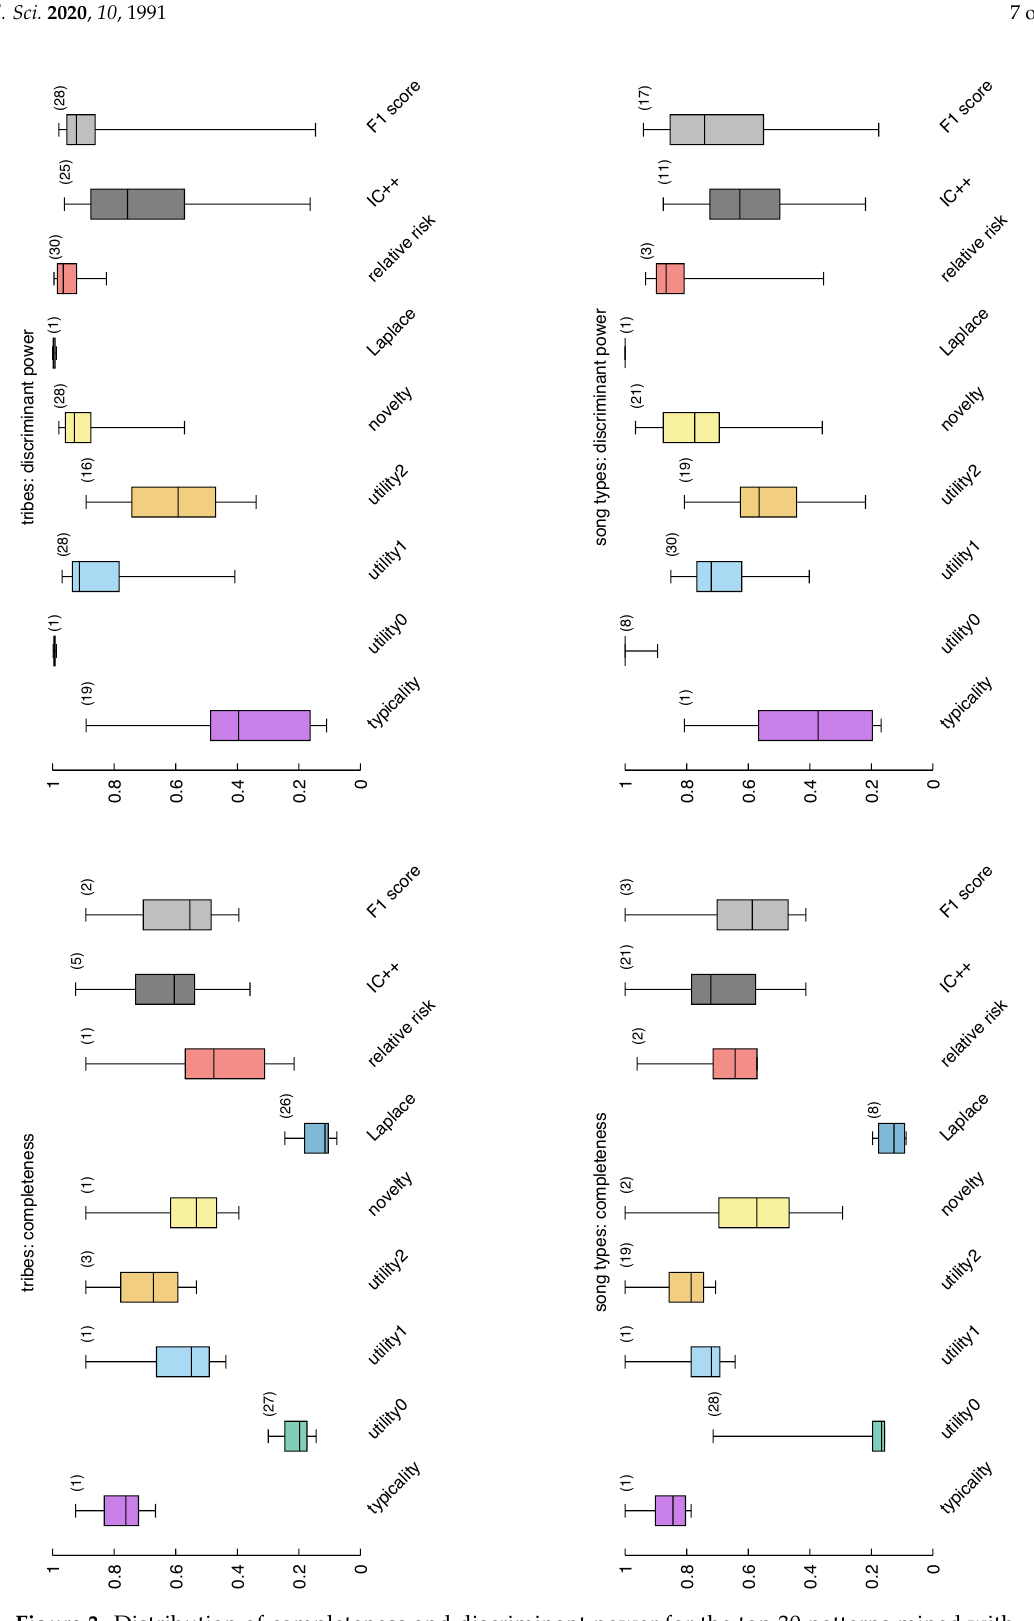
Figure 3. Distribution of completeness and discriminant power for the top 30 patterns mined with different pattern interestingness measures (minimum association support 3%, maximum pattern size 4). Numbers in brackets indicate the rank of the maximally complete resp. discriminant